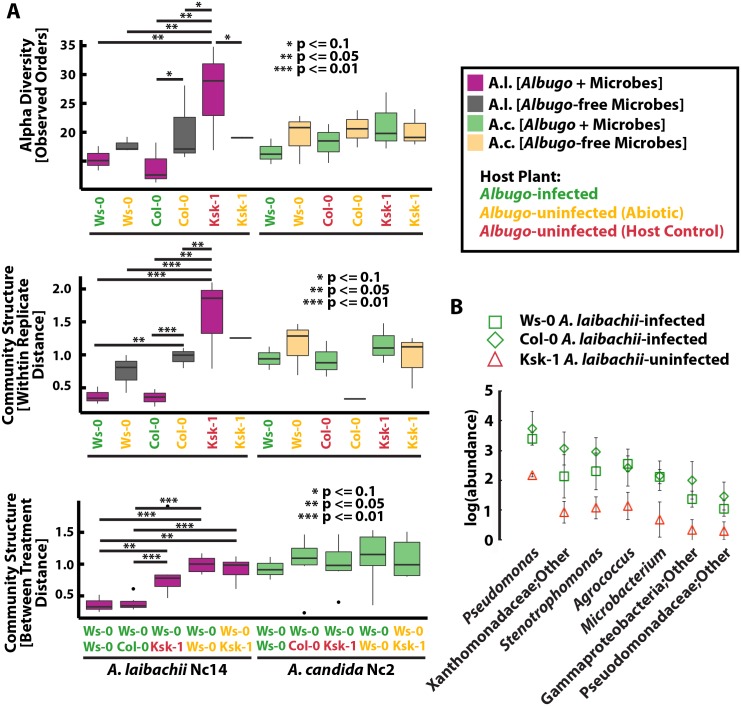
Experiment 4: Species of the obligate biotrophic pathogen and hub genus Albugo can affect colonization of microbes in the phyllosphere, linking abiotic or host genotype factors to a mechanism for observed microbial community variation.A. When Alb. laibachii Nc14 or Alb. candida Nc2 are absent due to abiotic (physical spore removal) or host (resistance) factors, the pathogen-associated microbial community increases in alpha diversity (also see S12 Fig) is less replicable (A. laibachii only) and shifts significantly (A. laibachii only). B. Several genera of bacteria were observed to more efficiently colonize the endophytic compartment of the phyllsophere in plants infected with Albugo sp. than in controls. For A and B: Ws-0: A. thaliana Ws-0, Col-0: A. thaliana Col-0, Ksk-1: A. thaliana Ksk-1. Green: Susceptible hosts, Red: Resistant hosts, Yellow: Filter removal of Albugo on all hosts. (S1_Data.xlsx)